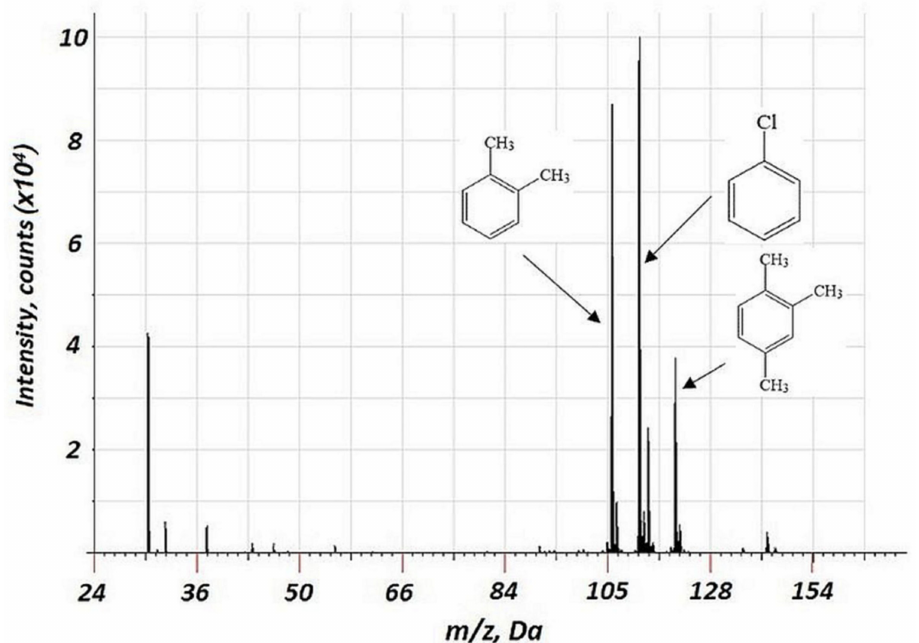
Figure 1. Background corrected mass spectrum range of 3 VOCs (chlorobenzene, p- xylene, and 1,2,4-trimethylbenzene) obtained using a flat copper cathode. Acquisition parameters were as follows: repelling pulse delay 200 µ s, pulse duration 1.2 µ s, pulse period 900 µ s, discharge pressure 213 Pa; the concentration of all VOCs of 15